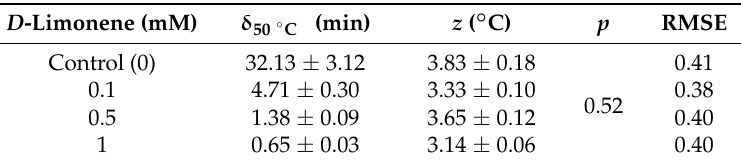
Table 1. Summary of the model fit to the survival curves of S. Senftenberg in Tryptic Soy Broth (TSB). Estimated values and standard deviations of the parameters of the Mafart model, as well as the Root Mean Squared Error (RMSE) of the fitted curves. The value of p was fixed to 0.52 for every model calibration.